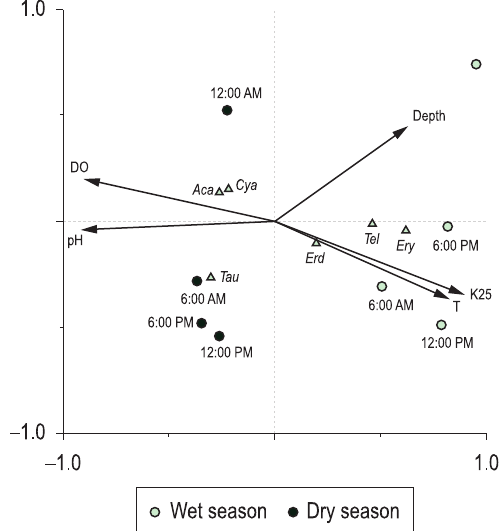
Figure 2. CCA ordination (axes 1 and 2) among abundance of Odonata larvae, abiotic variables, and sampling hours (6:00 AM, 12:00 PM, 6:00 PM, and 12:00 AM) during rainy and dry seasons. (Abbreviations, see Tables 2 and